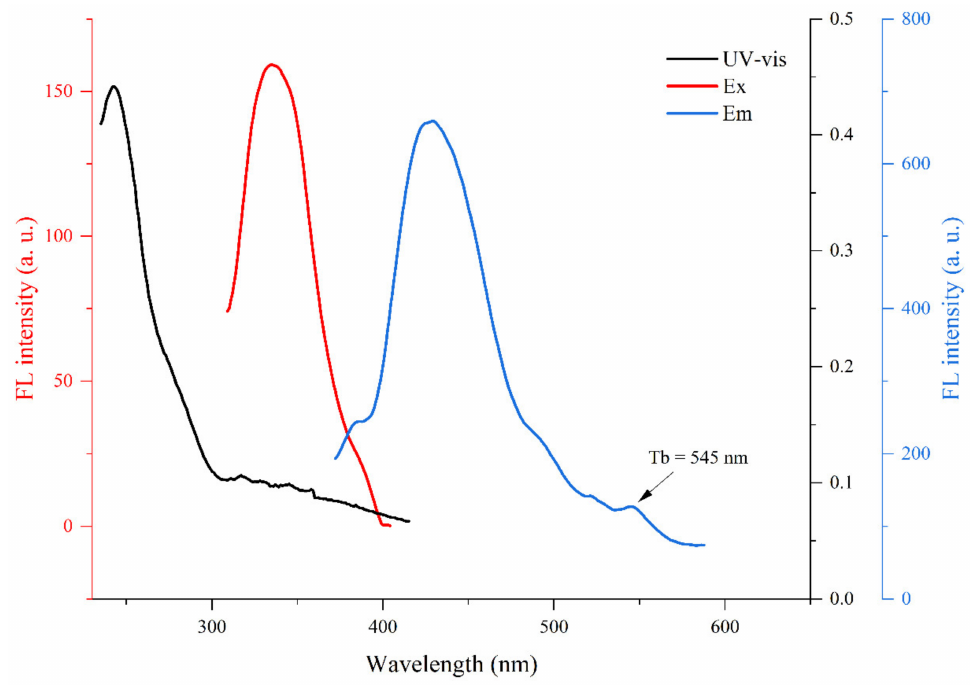
Figure 10. The excitation/emission spectra and UV-vis absorption of the Tb@NH 2 -MIL-253 (Al)